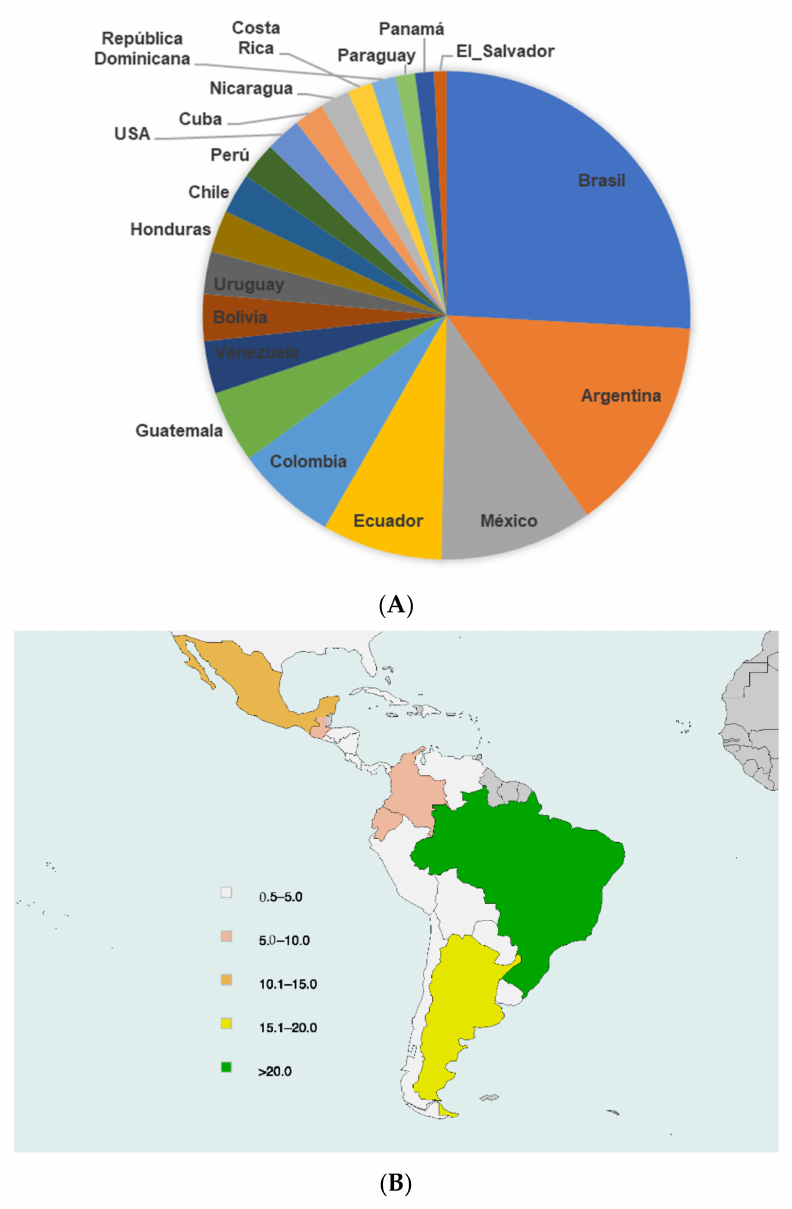
Figure 1. ( A ) Relative percentage of participating members of every country from Latin Amer- ica. ( B ) Percentage of participating members from each country in relation to the total number of participants from all Latin American